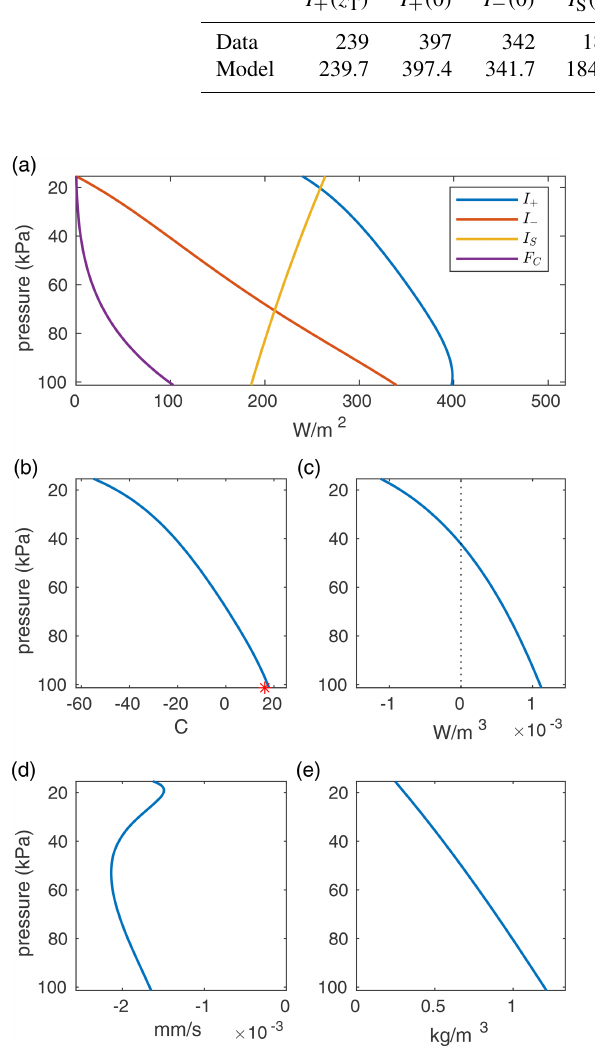
Figure B2. Temperature profiles for best fits for each of the forms of φ and ψ . Panels (a) and (b) correspond to Eq. (A55) for φ and panels (c) and (d) to Eq. (A56), and similarly, panels (e–h) corre- spond to Eqs. (A57) and (A58), respectively. Panels (a) , (c) , (e) , and (g) correspond to Eq. (A52) for ψ , while panels (b) , (d) , (f) , and (h) correspond to Eq. (A53). The data from Cronin and Jansen (2016) are the red circles. The numbers in the bottom left are the residuals for the